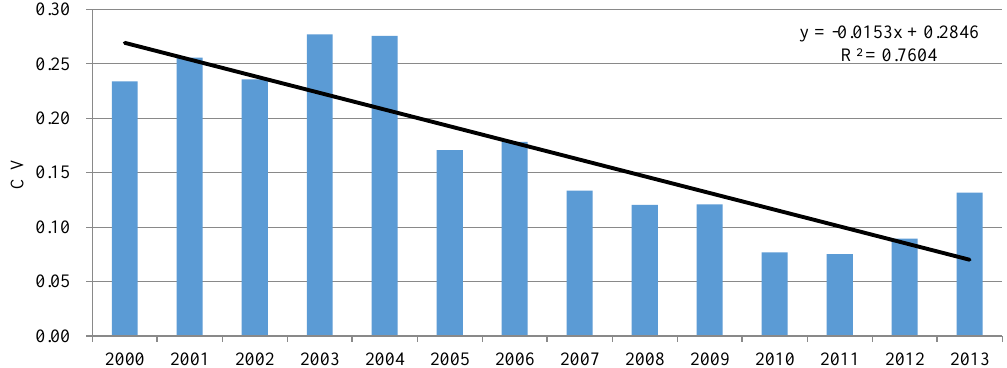
Figure 12. Variation in shadow prices across the 30 provincial power grids. Note: CV stands for coefficient of variation.